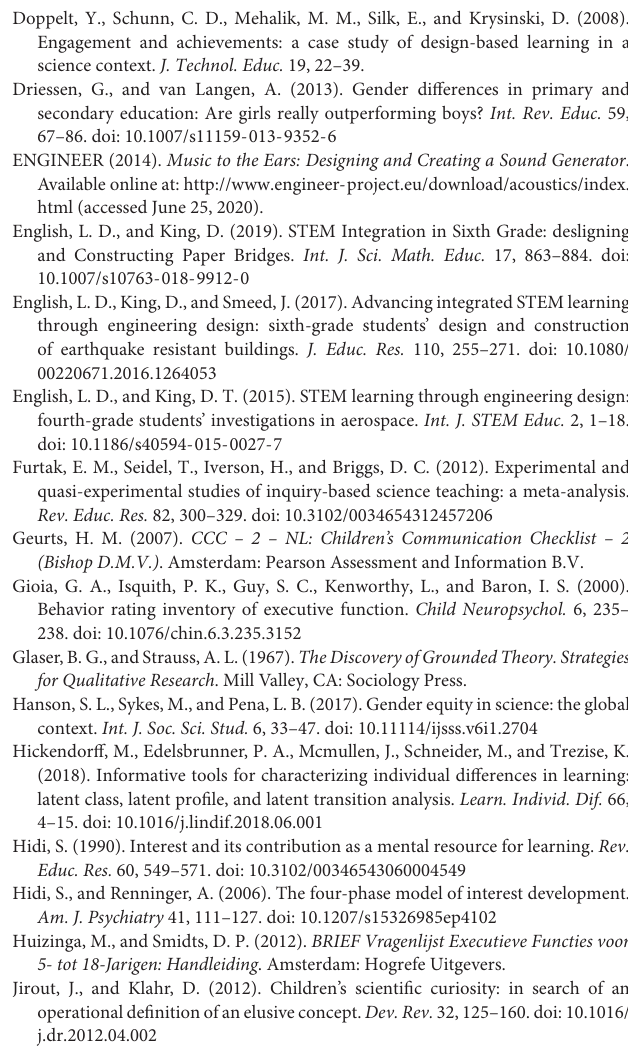
Supplementary Data Sheet 1 | Attitude questionnaire items. Supplementary Data Sheet 2 | Interview protocol. Supplementary Data Sheet 3 | Factor analysis. Supplementary Data Sheet 4 | Correlation table. Supplementary Data Sheet 5 | Latent class analysis-content knowledge test. Supplementary Data Sheet 6 | Content knowledge test